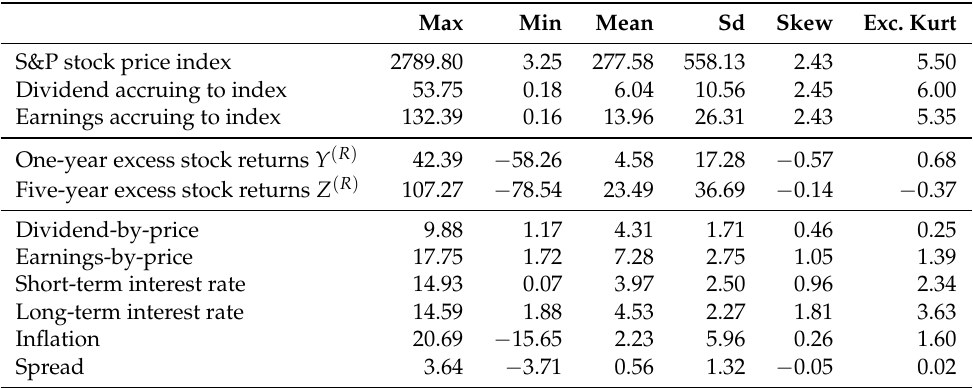
Table 1. US market data